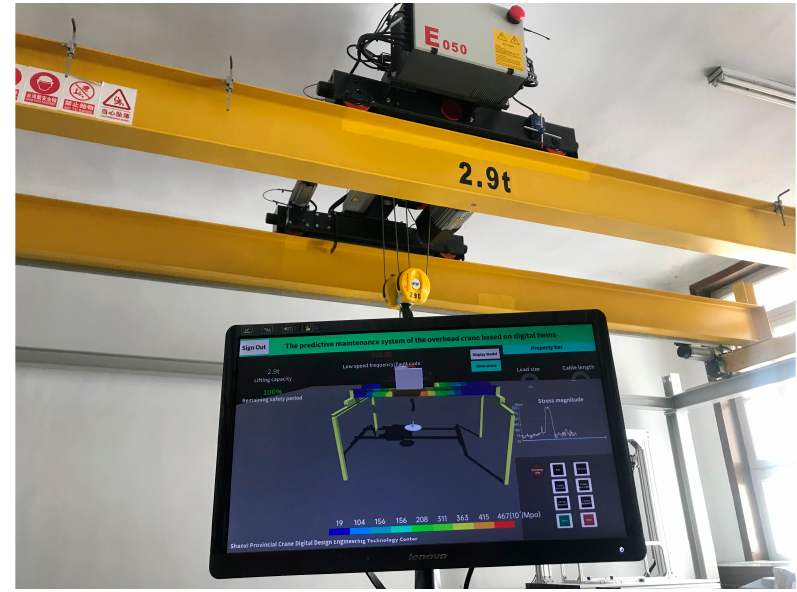
Figure 9. The digital twin experiment platform.